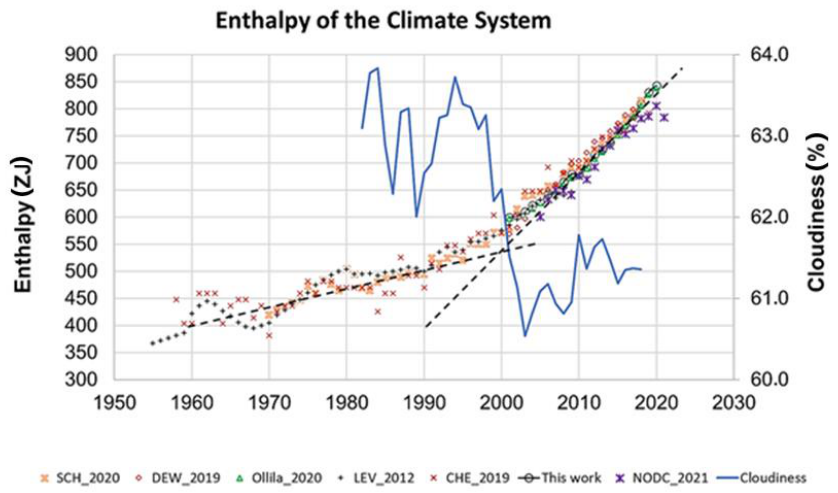
Figure 14. Expanded enthalpy plot. The cloudiness [20] is included (right scale). The rise of the enthalpy after the millennium coincides with the drop of cloudiness. The latest OHC data from NODC exhibit such a flatter tendency for about one year.